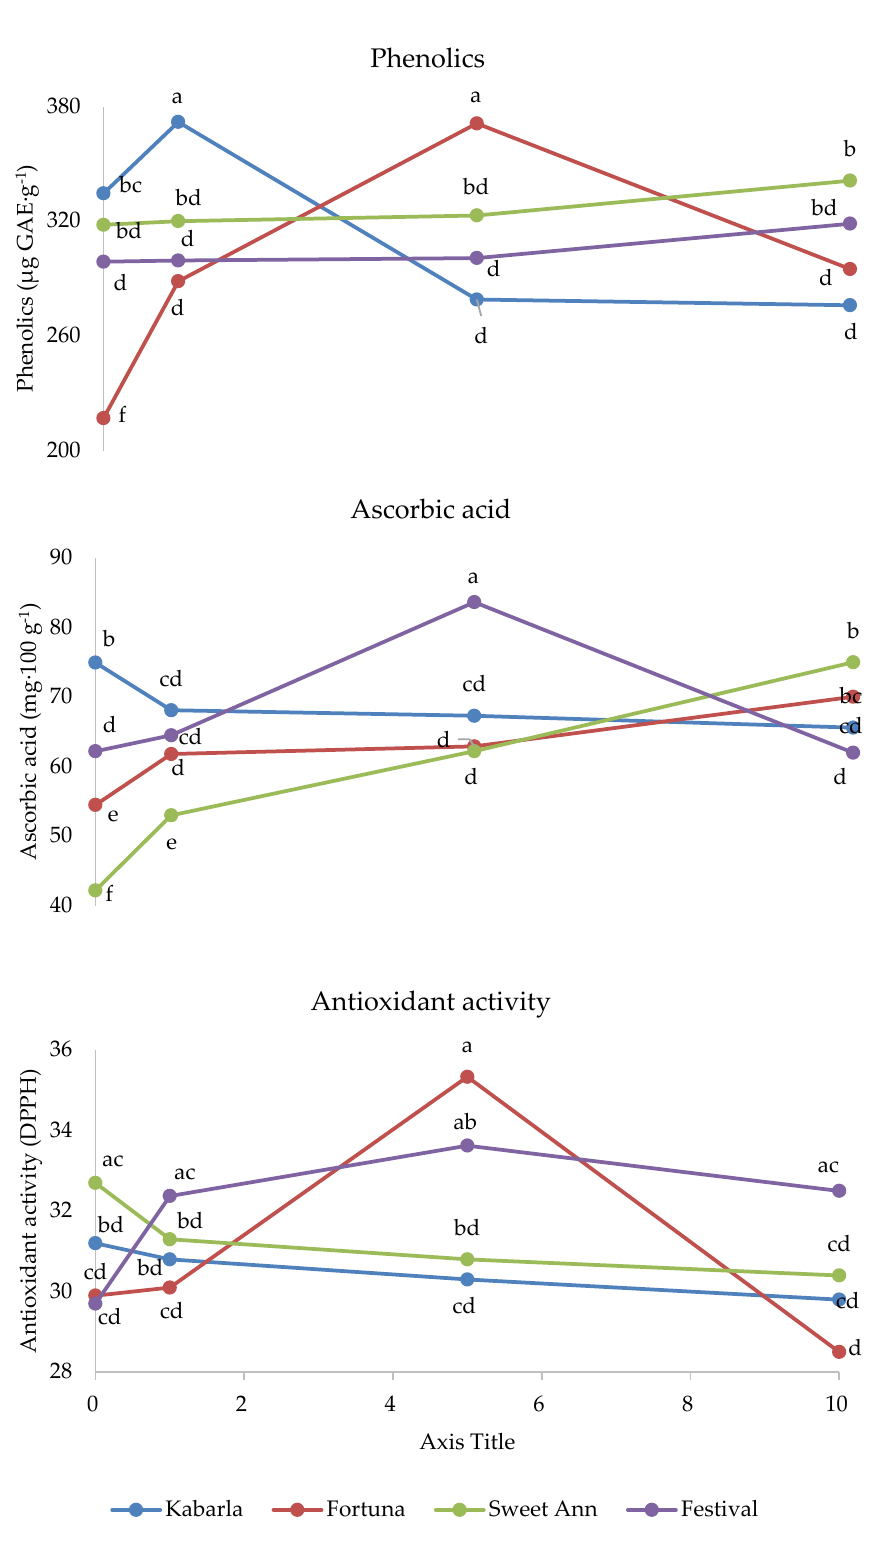
Figure 4. Interaction between Crop system and Melatonin dose on total phenolics and ascorbic acid 271 content of strawberry fruits grown in Isparta region (Turkey), the values followed by different let- 272 ters are statistically different according to Tukey’s HSD test at p ≤ 0.05.